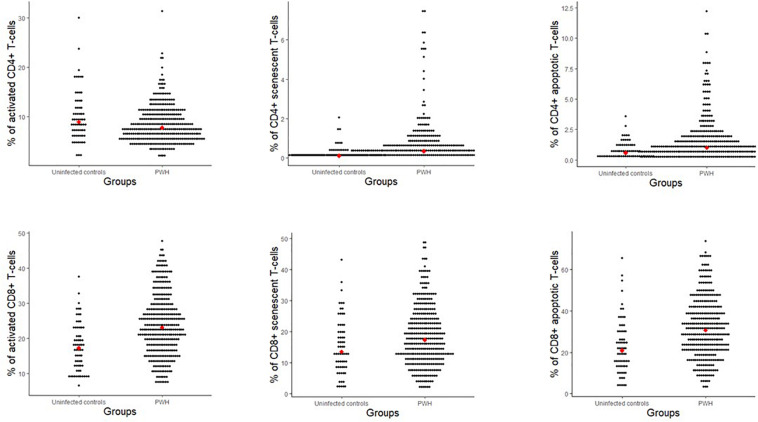
Proportions of T-cell subsets (% of CD4+ and CD8+) for people with HIV and uninfected controls matched on age. Red dot indicates the median value. Activation (CD38+ HLA-DR+), senescent (CD28-CD57+), and apoptotic (CD28-CD95+).